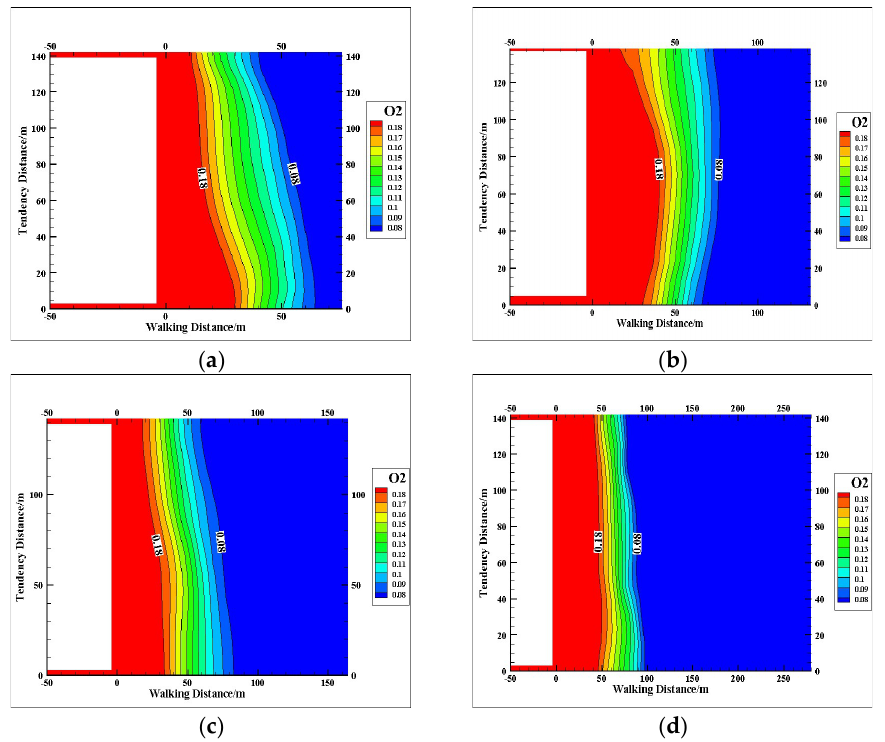
Figure 7. Oxygen concentration distribution in the mining area of stage Ⅰ ~ Ⅳ : ( a ) Stage I, ( b ) Stage II, ( c ) Stage III, ( d ) Stage IV.